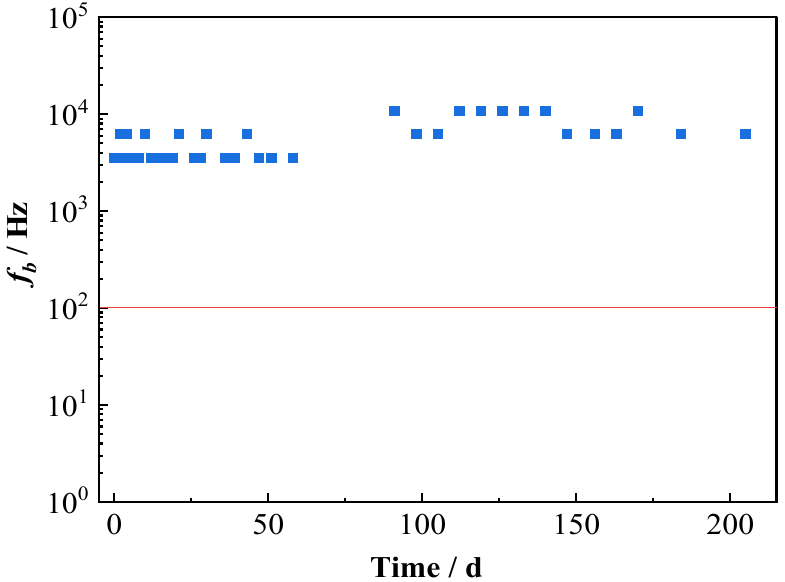
Figure 7. Variation of f b with time for T700/VE composite specimen.